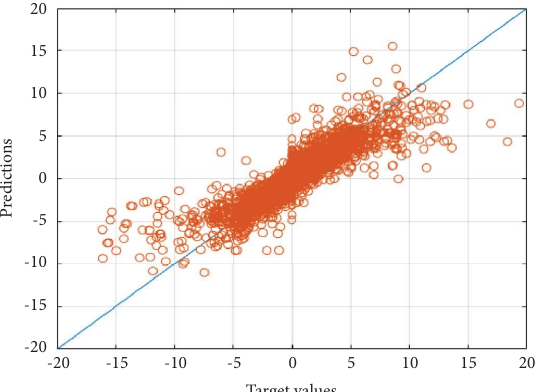
Figure 6: Target values vs. RBF predictions using the proposed features with over-20 evaluation fltering.